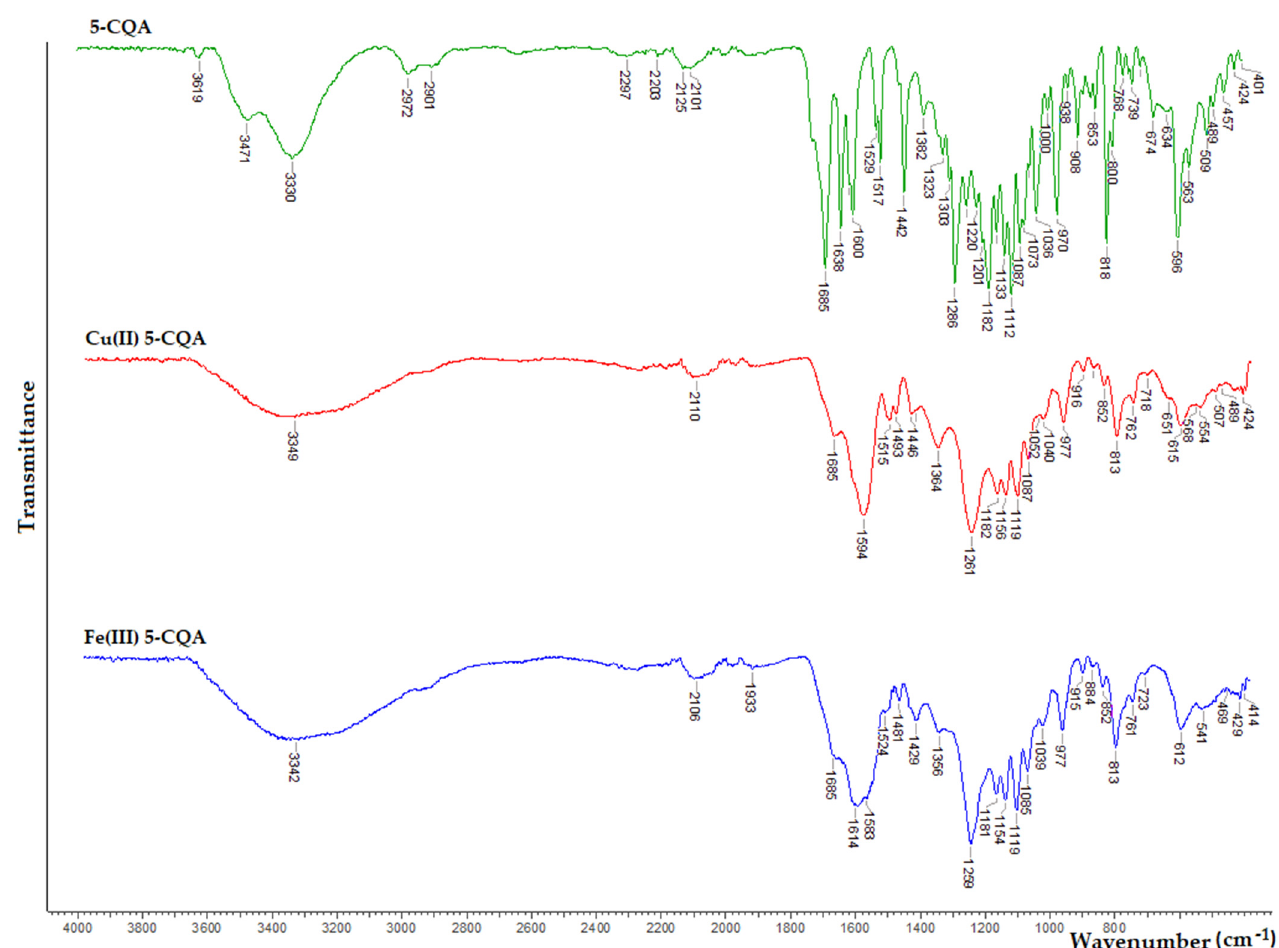
Figure 4. FT − IR spectra of chlorogenic acid and its